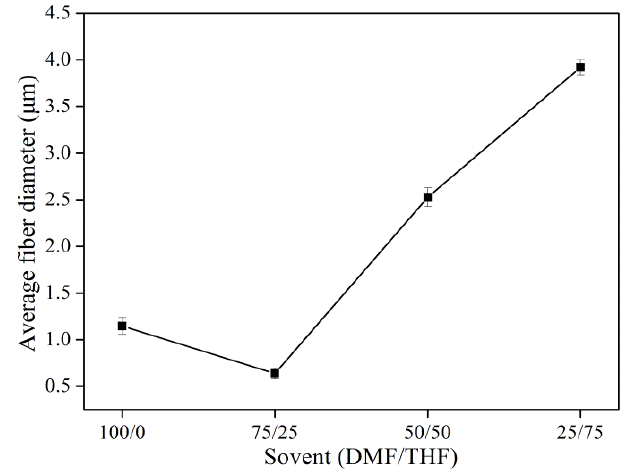
Figure 3. Average fiber diameter of electrospun PS fibers with different solvent combinations.